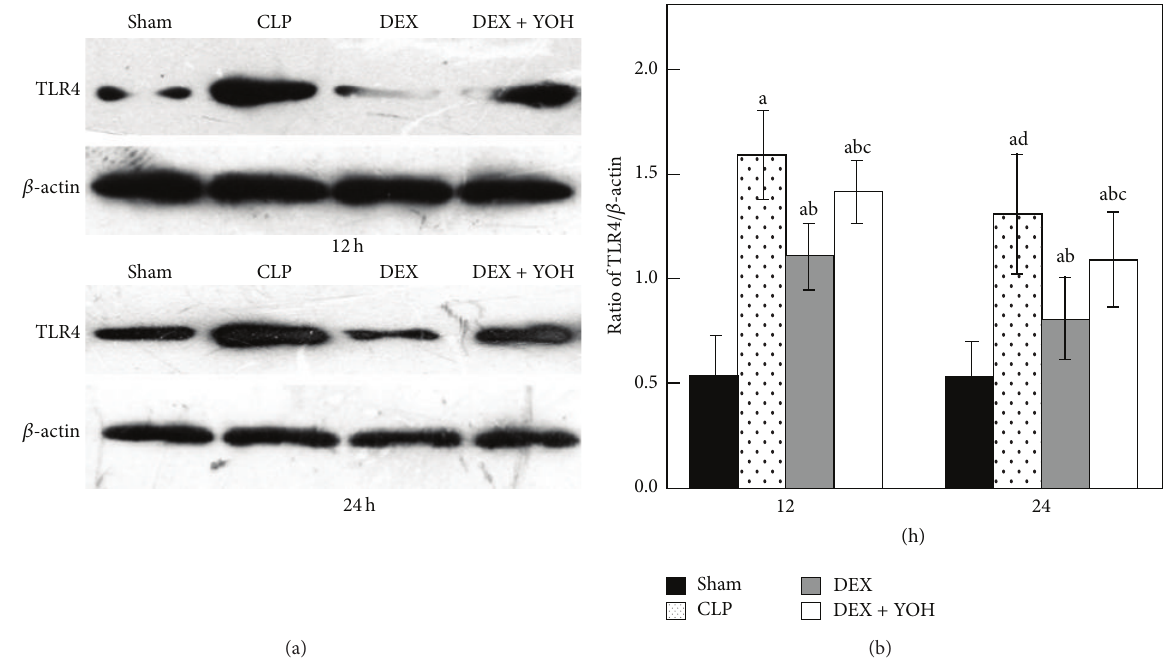
Figure 5: Expression of TLR4 in intestine by Western blotting in experiment rats among four groups ( 𝑛 = 8 ). Data are expressed as mean ± SD. a 𝑃 < 0.05 , versus Sham group; b 𝑃 < 0.05 , versus CLP group; c 𝑃 < 0.05 , versus DEX group; d 𝑃 < 0.05 , versus CLP group